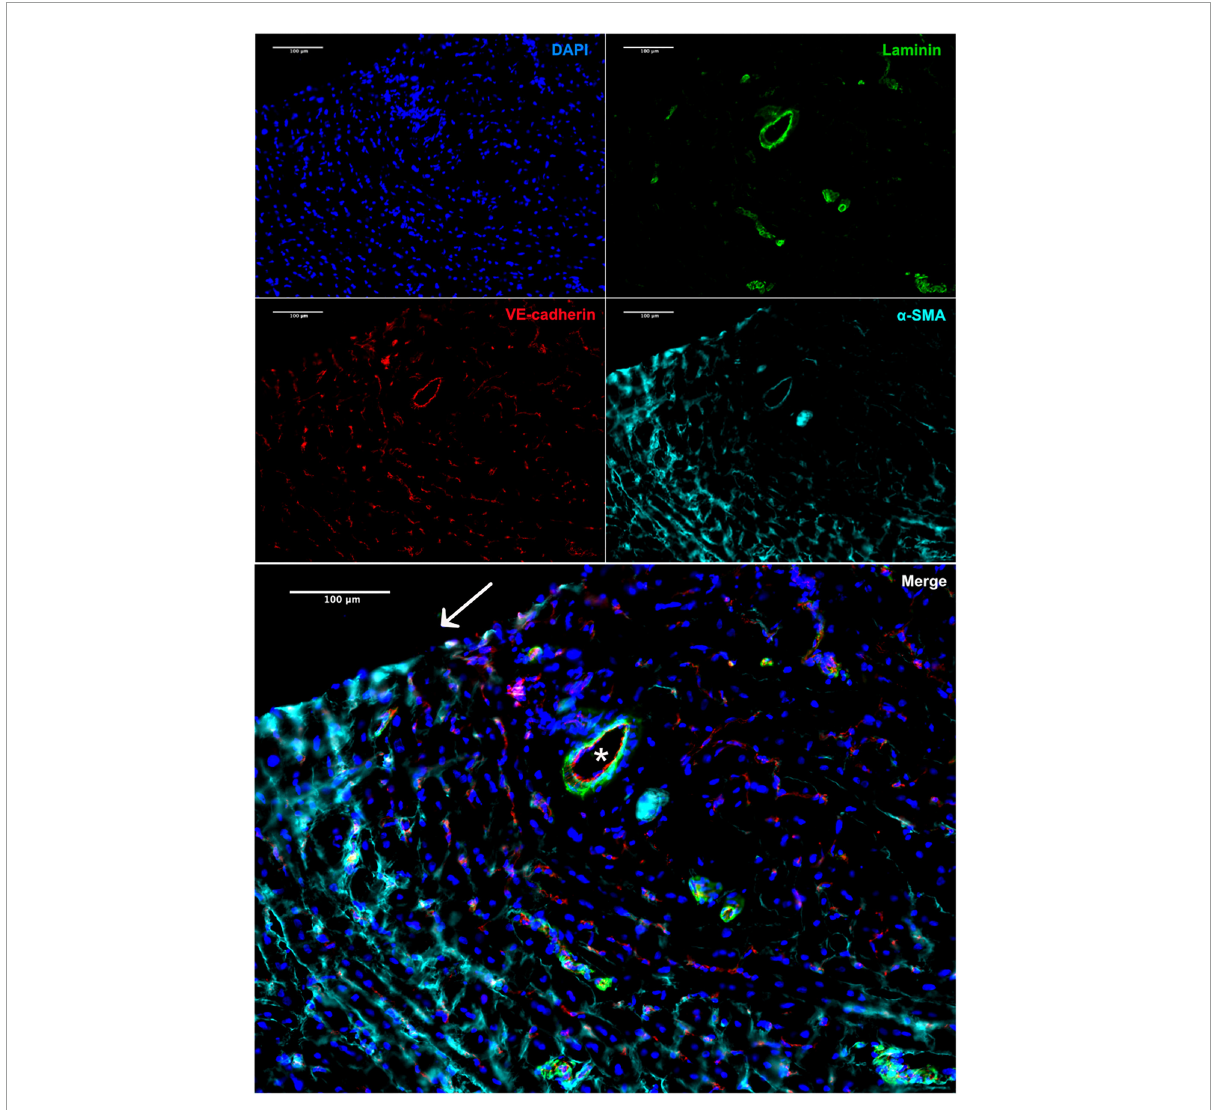
FIGURE6 Immunofluorescence staining of the explant 4 weeks after implantation. Vasa privata (*) within the remodeled BC-vascular graft wall (anti-VE-cadherin in red, anti- α SMA in cyan, and anti-laminin in green). Nuclei were stained with DAPI. Scale bar = 100 µ